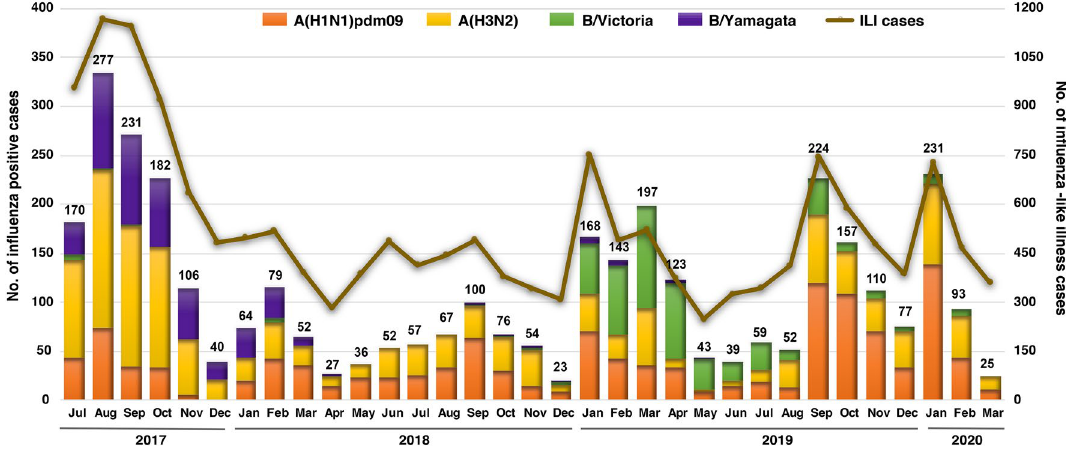
Figure 1. Monthly distribution of influenza A and B viruses from July 2017 to March 2020 (n = 17,480). Numbers above the bar graph indicate the monthly number of influenza virus-positive samples (left Y-axis) with respect to the monthly ILI samples (right Y-axis). The bar graph was generated by using Microsoft Excel (Office